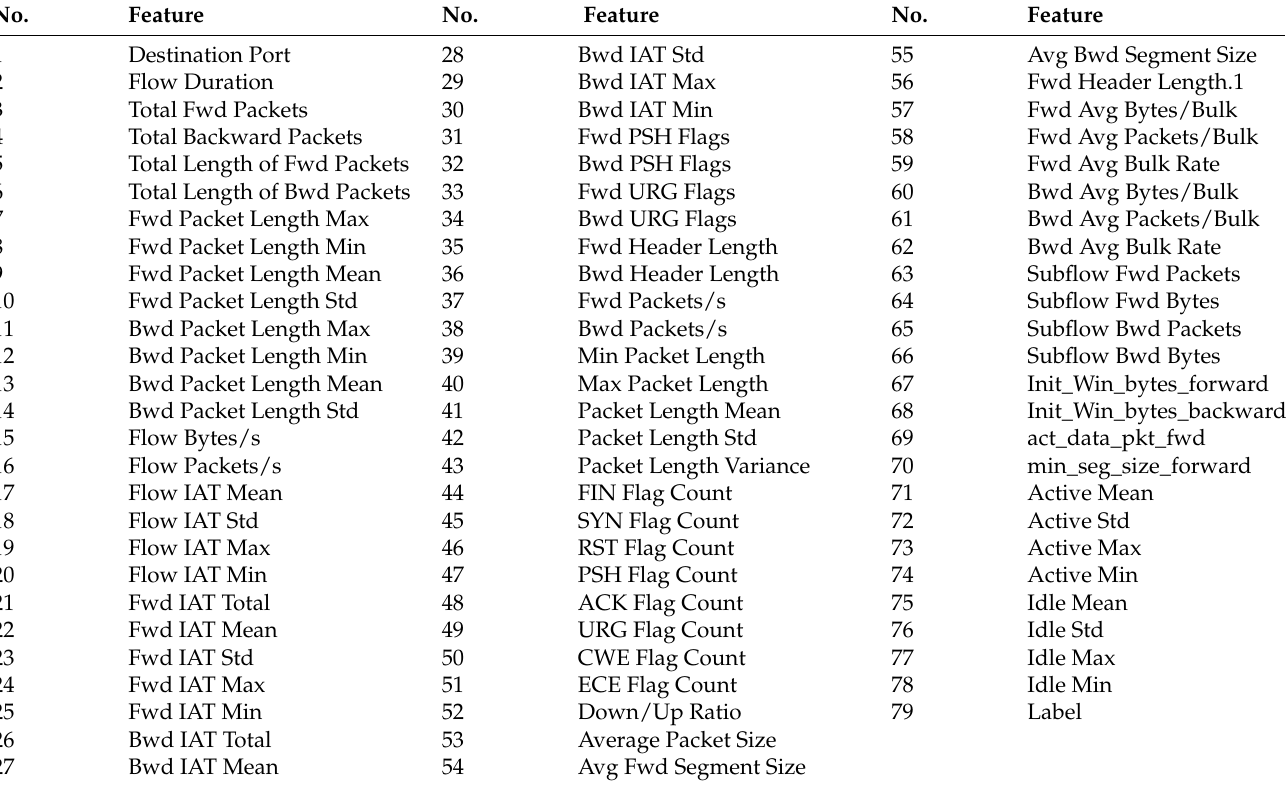
Table 1. Dataset